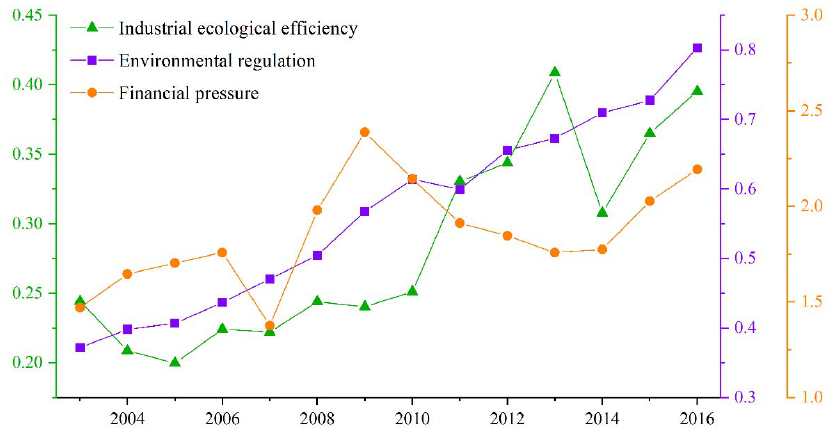
Figure 3. Temporal evolution of IEE, financial pressure, and environmental regulation.